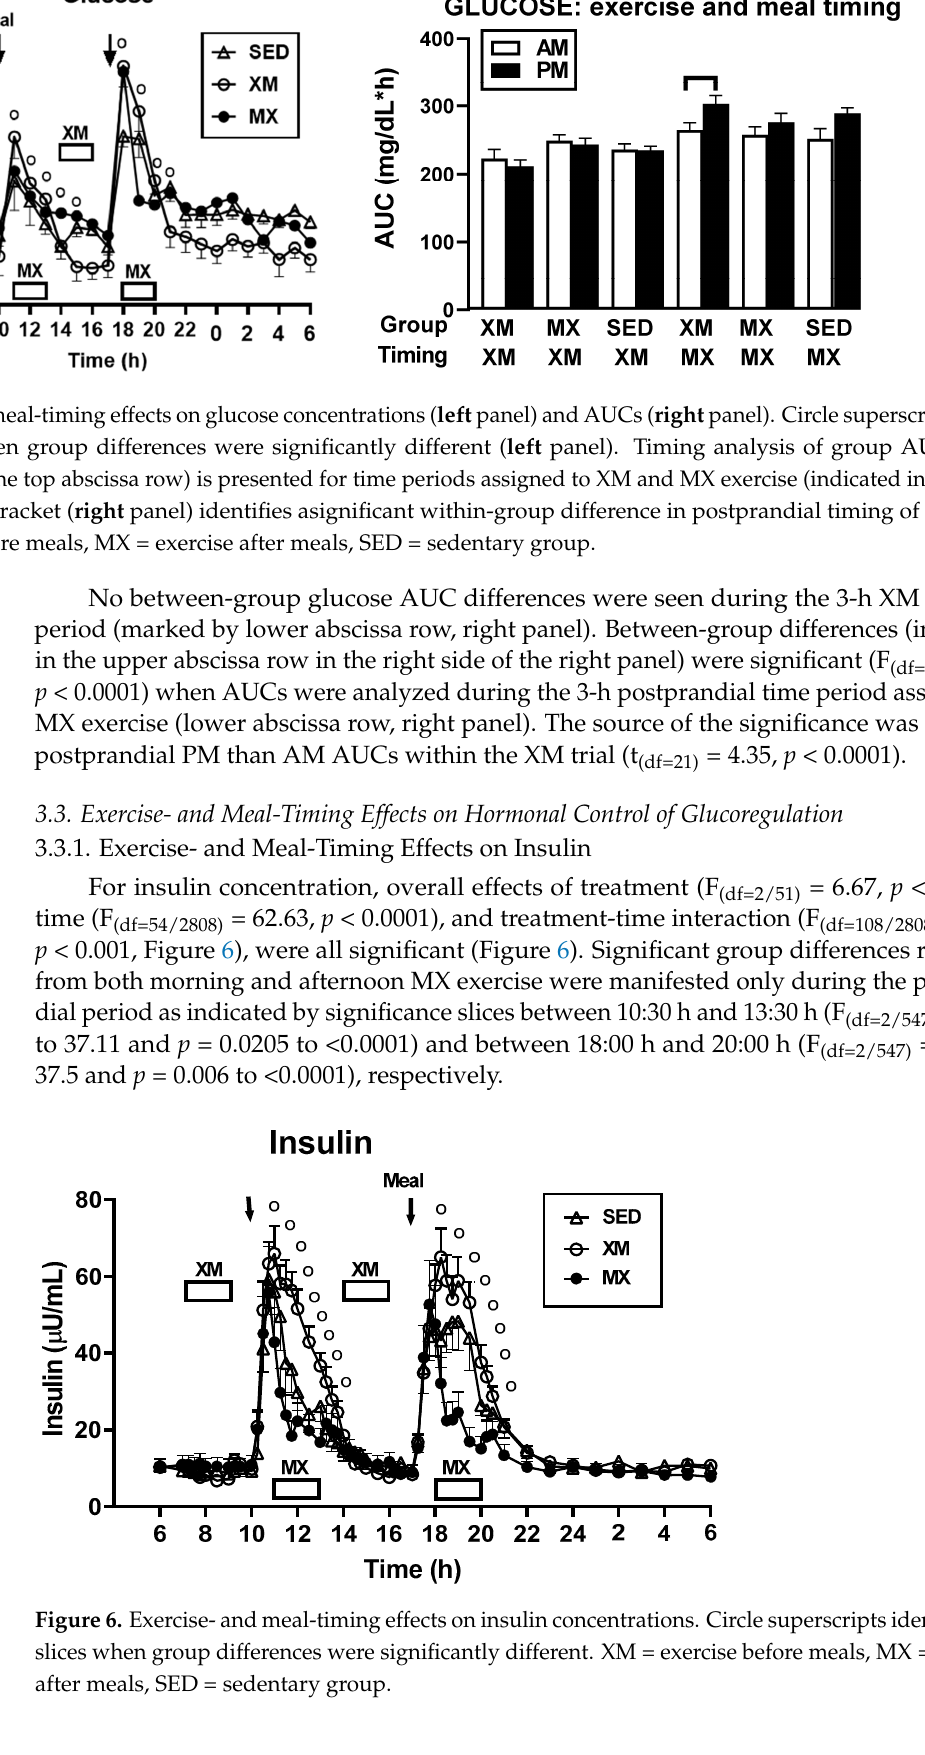
11 of 25 Figure 4. Exercise- and meal-timing effects on BHB exercise and prandial AUCs. Exercise-timing AUCs represent 2 h of exercise and one post-exercise hour. Meal-timing AUCs represent 7 postprandial hours.In the exercise analysis, afternoon XM ketone AUC was significantly higher than AM MX and both AM and PM SED AUCs. Within XM trial, afternoon AUC was higher than the AM AUC ( left panel). In the prandial analysis, afternoon XM ketone AUC was significantly higher than AM MX AUC and the AM AUC within its own trial ( right panel).B rackets identify groups with significant between- and within-group differences. XM = exercise before meals, MX = exercise after meals, SED = sedentary group. 3.2.3. Exercise- and Meal-Timing Effects on Glucose Concentrations and AUCs Glucose concentration revealed no overall treatment effect, but showed significant